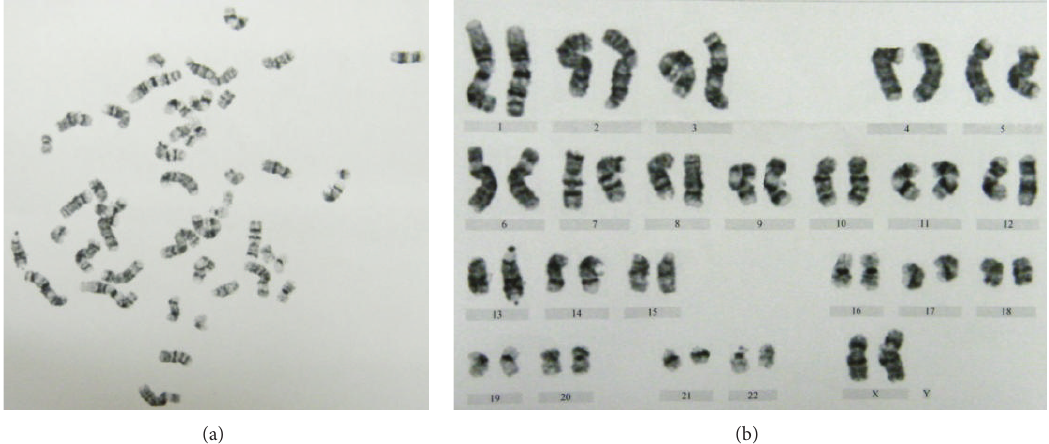
Figure 8: Karyotype analysis of hESCs grown on fixed xeno-free ECM after 25